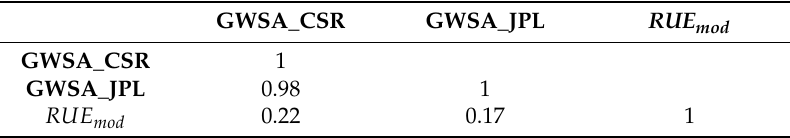
Table 3. Correlation between GWSA and 𝑅𝑈𝐸 (cid:3040)(cid:3042)(cid:3031) in Region C.